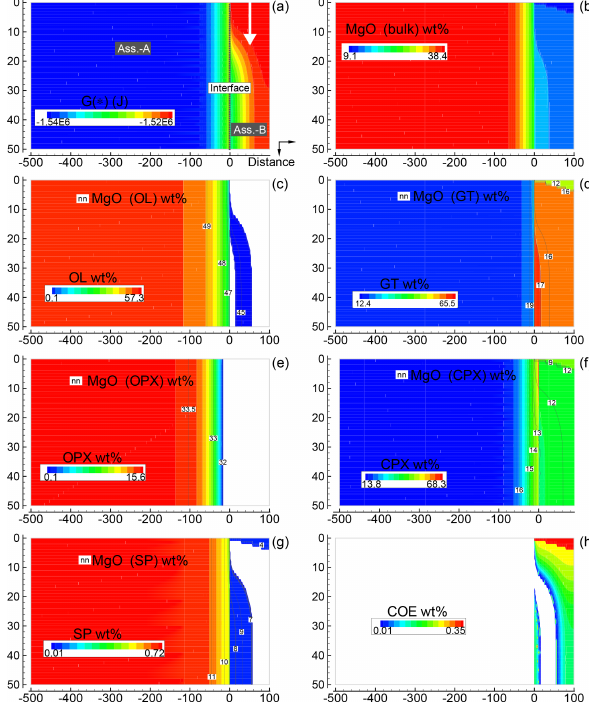
Figure 6. Solution of a 2-D model simulation at time 102400 (arbi- trary units). The starting proportion of the two assemblages is 5 : 1 ( f = 5). In this model it is assumed that at time 100000 a new as- semblage B enters from the top with velocity 0.00625 (arbitrary units). The description of the panels follows the caption of Fig.